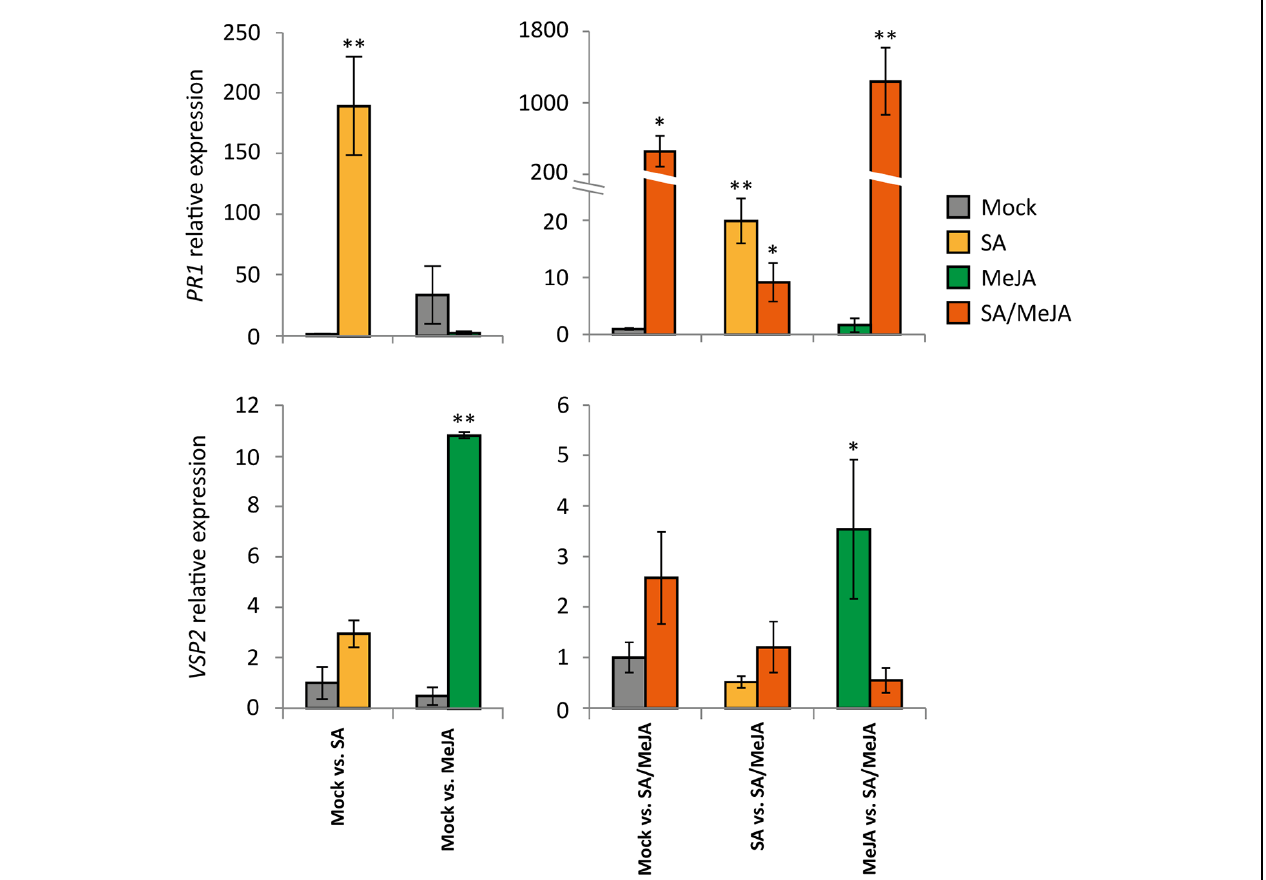
FIGURE 5 | Differential gene expression in competition-grown plants. RT-qPCR analysis of salicylic acid (SA)-responsive PR1 expression and Jasmonic acid (JA)-responsive VSP2 expression in competition-grown plants 24 h after treatment with a mock, SA, MeJA, or SA/MeJA solution. Mock vs. SA and Mock vs. MeJA competition experiments were performed in one experimental round, and Mock vs. SA/MeJA, SA vs. SA/MeJA, and MeJA vs.